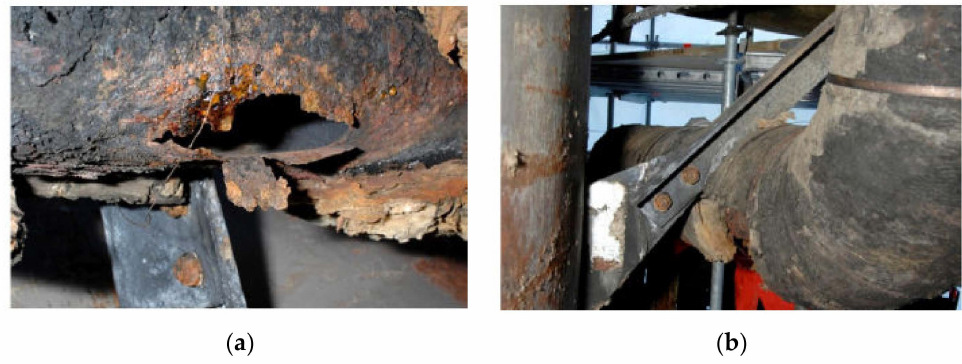
Figure 4. CUI failure in a refinery plant: ( a ) pipework fracture detail with a huge hole and ( b ) the installation of walkway bracket touching the pipework. Reprinted with permission from Ref. [23]. Copyright 2013